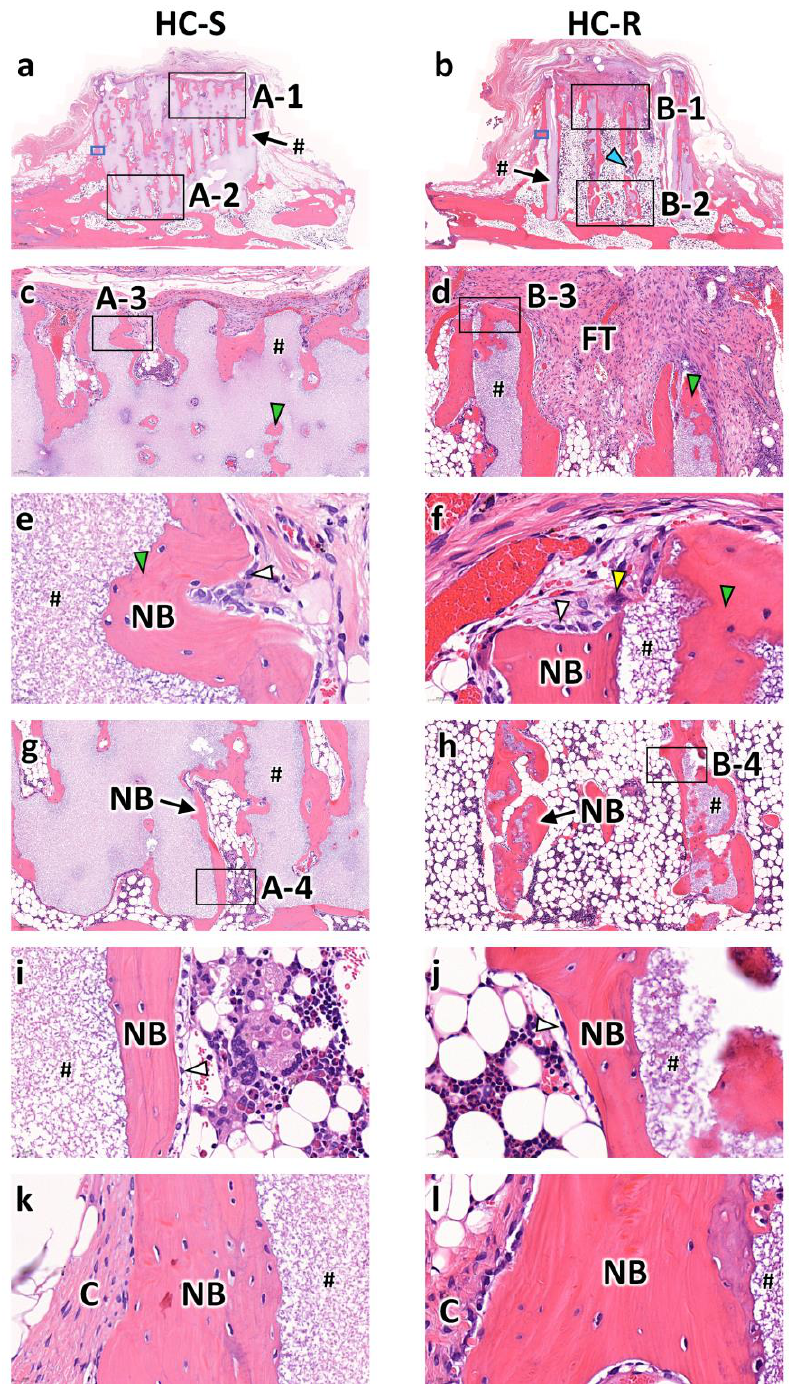
Figure 4. Hematoxylin and eosin (H&E)-stained sections at 12 weeks after implantation of honeycomb scaffolds with square channels (HC-S) ( a ) and honeycomb scaffolds with rectangle channels (HC-R) ( b ) on the rabbit calvaria. High magnification images of regions A-1 ( c ), B-1 ( d ), A-3 ( e ), B-3 ( f ), A-2 ( g ), B-2 ( h ), A-4 ( i ), and B-4 ( j ). High magnification images of regions enclosed in blue squares in Figure 4a ( k ) and Figure 4b ( l ). #, NB, FT, and C indicate scaffold struts, new bones, fibrous tissue, and collagen fiber, respectively. White, yellow, blue, and green arrowheads indicate osteoblasts, osteoclasts, resorbed part of the strut, and new bone formed in the resorbed strut part, respectively.